Question: What does this figure show? Answer in one sentence.
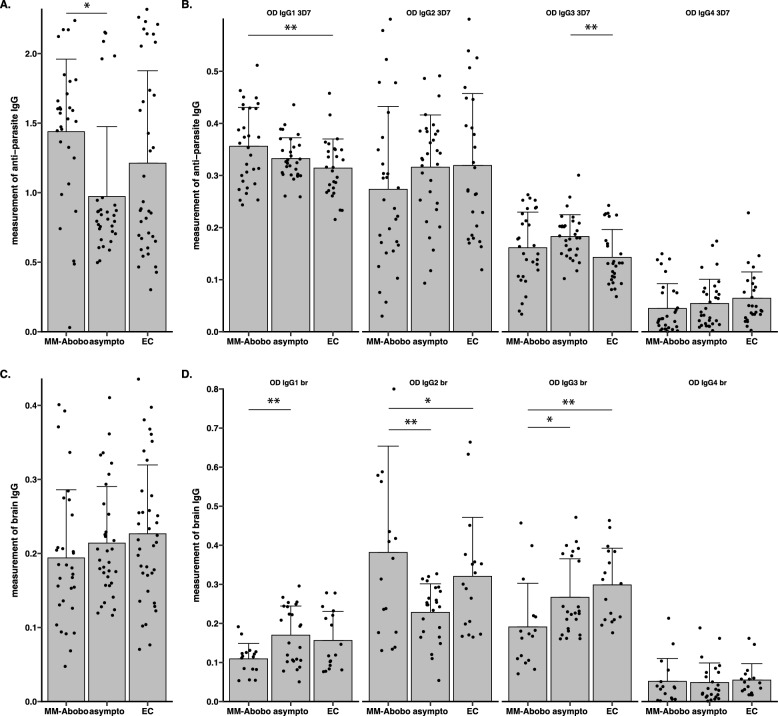
Answer: IgG and subclass patterns against brain and parasite extract antigens in different malaria groups of Abobo. Antibody responses, expressed as OD (Optical density), are plotted as a box plot. A Antibody IgG response against total parasite antigens, B distribution of the subclasses (IgG1, IgG2, IgG3, and IgG4) against parasite antigens. C IgG response against brain antigen in malaria groups. D Subclasses (IgG1, IgG2, IgG3, and IgG4) against brain antigens in malaria groups. MM: mild malaria; AS: Asymptomatic carrier; EC: endemic control. Asterisks indicate statistically significant differences between groups (* p < 0.05; ** p < 0.01; *** p < 0.001)